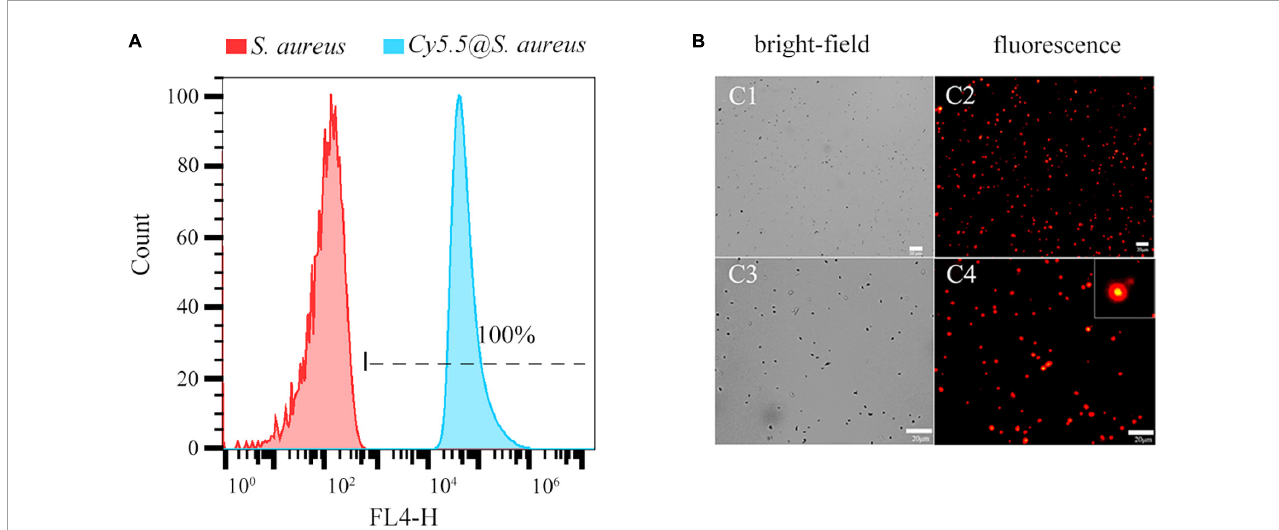
FIGURE2 (A) Flow cytometry analysis of Staphylococcus aureus labeled with Cy5.5 by heat shock (FL4-H channel). Representative examples of unlabeled bacteria (red area) and Cy5.5@S. aureus (blue area) are shown. (B) Fluorescence micrographs of S. aureus after being labeled with Cy5.5 using a heat shock method, with Cy5.5@S. aureus shown in red (scale bar: 20 µ m, the exposure time: 150